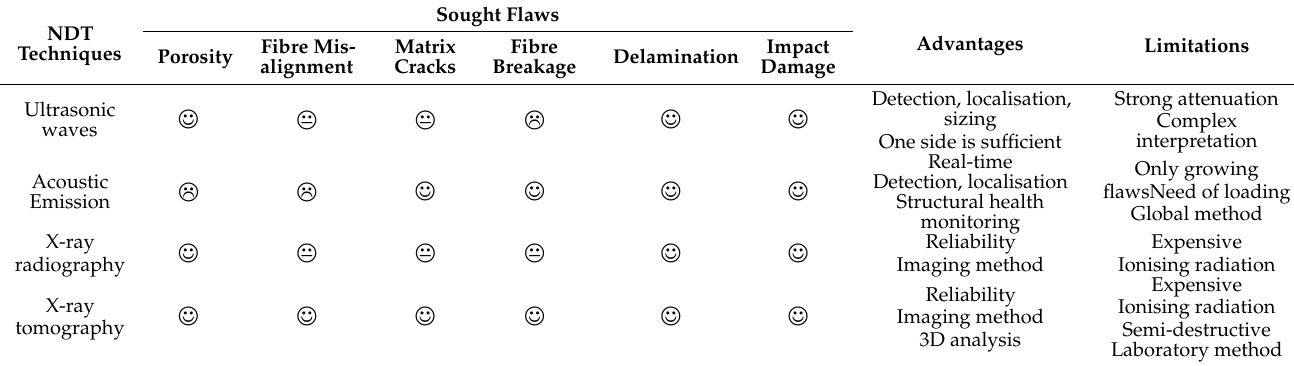
Table 1. Comparison of different surface non-destructive techniques.